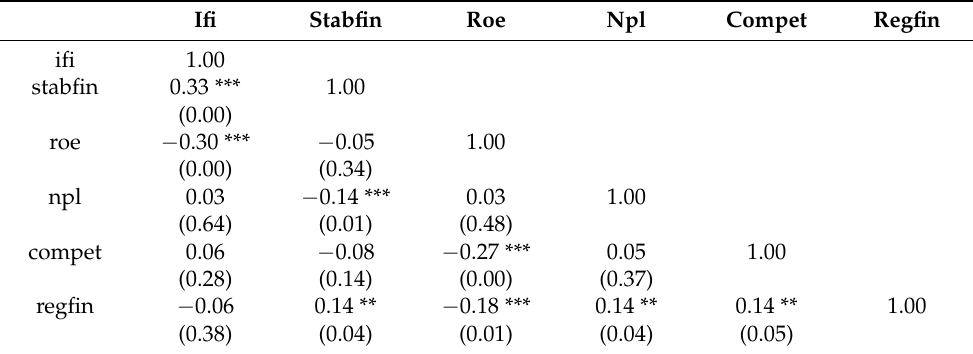
Table A4. Correlation matrix for main variables, LAC sample only.